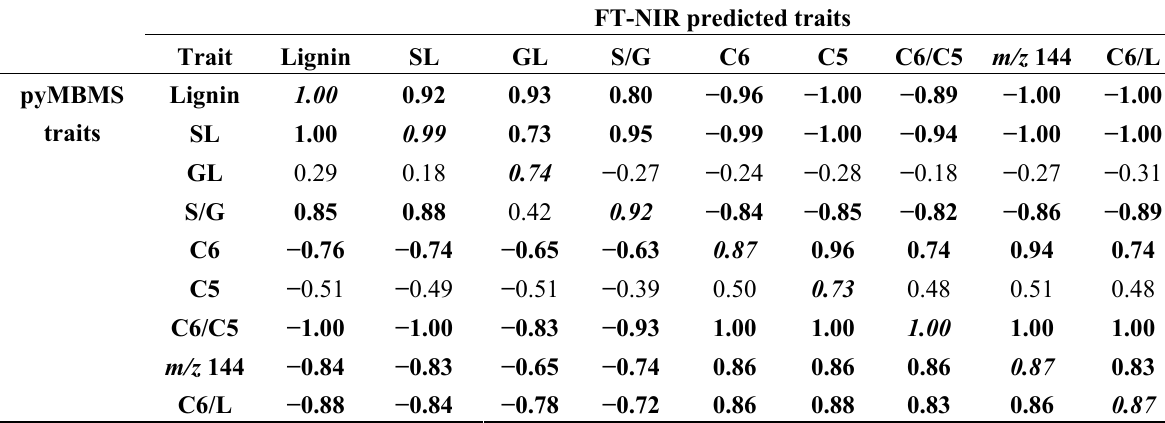
Table 4. Pair-wise estimates of genotypic correlations between pyMBMS and FT-NIR. FT-NIR predicted